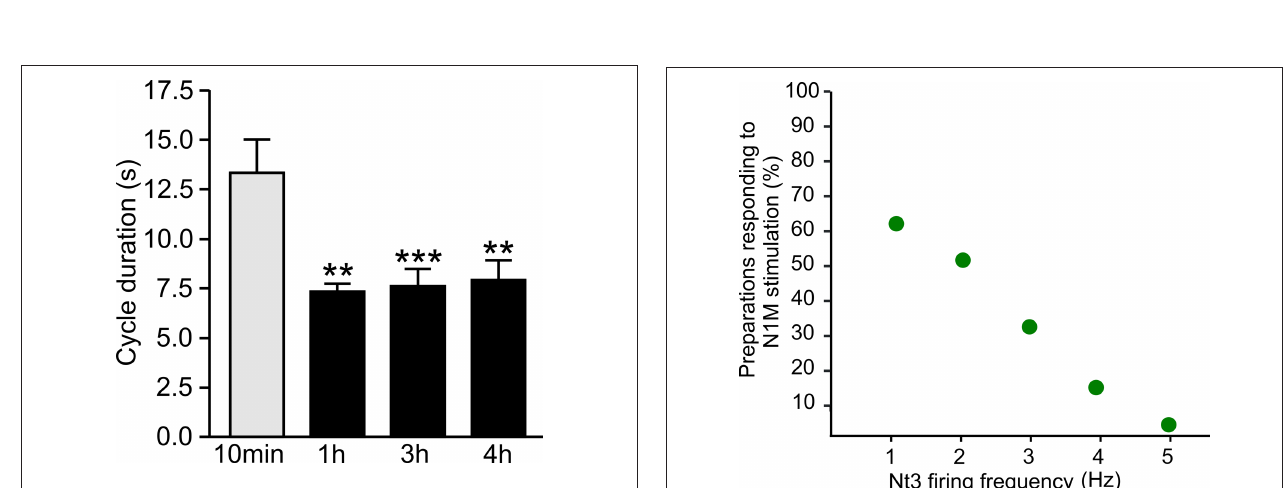
Figure 5 | inverse correlation between N3t firing rate and frequency of fictive feeding response. (A) The N3t frequency before CS application was compared with the conditioned fictive feeding response measured as a difference score. There is a